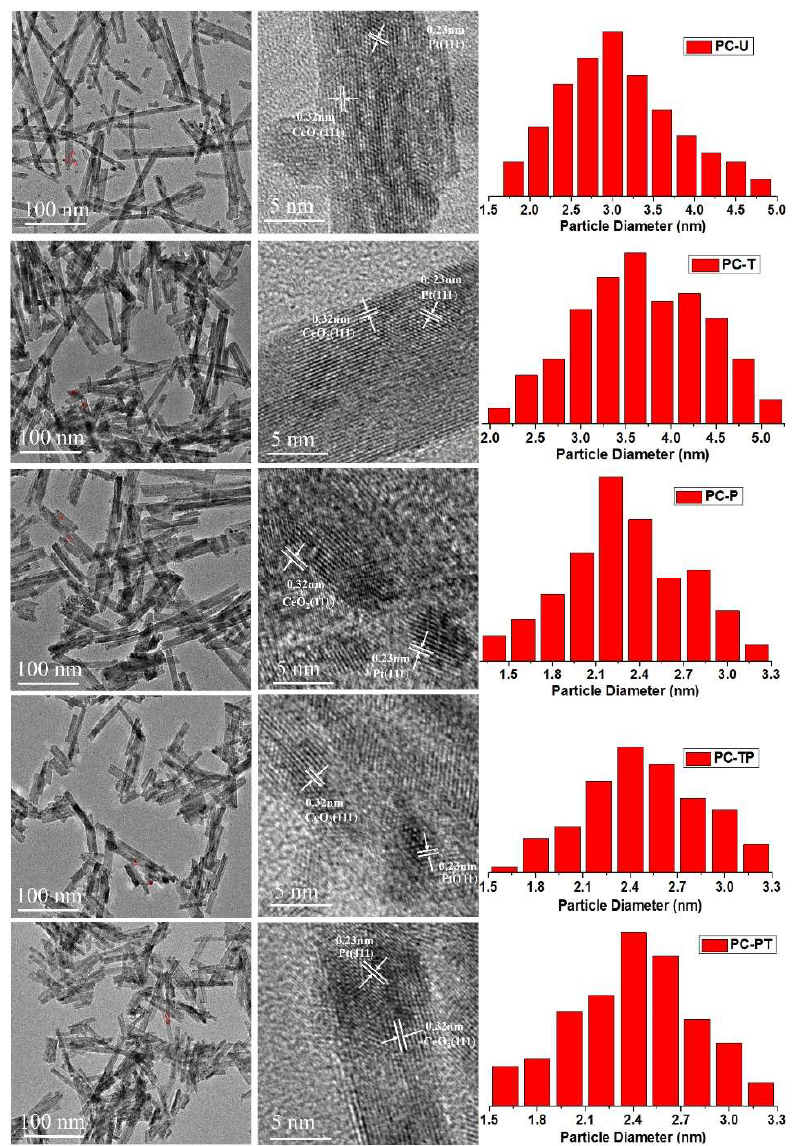
Figure 3. TEM image images of samples and size distribution of Pt particles on CeO 2 support.